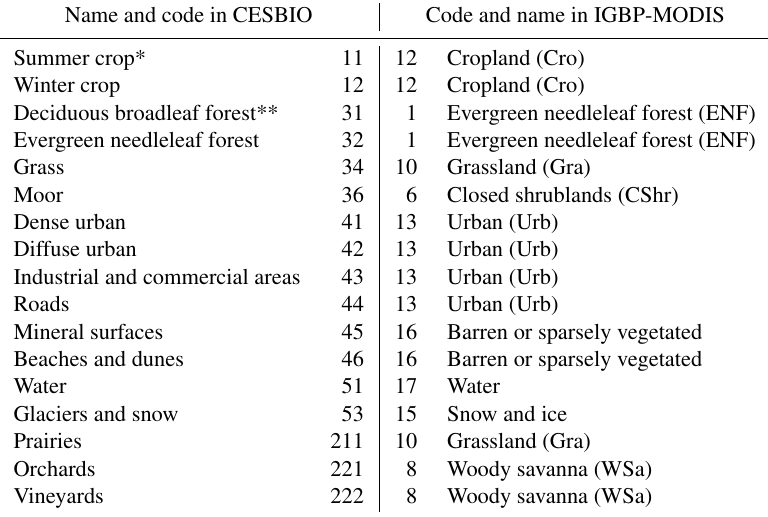
Table A1. LC categories in CESBIO and respective transformation to the IGBP-MODIS LC categories. The respective codes of each dataset are included in the central columns. * All crop types were transformed to the single cropland category available in IGBP-MODIS; however, most of the crop types in the area were summer crop (mainly corn). ** Deciduous forests were transformed to the LC category of evergreen needleleaf forest (conifers), even when a deciduous broadleaf forest category was available in IGBP-MODIS. This was done due to the lack of measurements over deciduous trees, which resulted in the area-averaged maps used to evaluate the model being constructed with data from the conifers; this strategy allowed a fairer model–observation comparison. Abbreviations used in the text and figures are indicated with